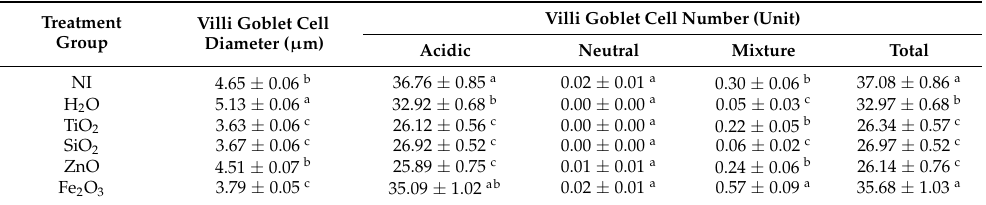
Table 6. Effects of intraamniotic administration of experimental food-grade NP solutions on villi goblet cell diameter, goblet cell count, and goblet cell type 1